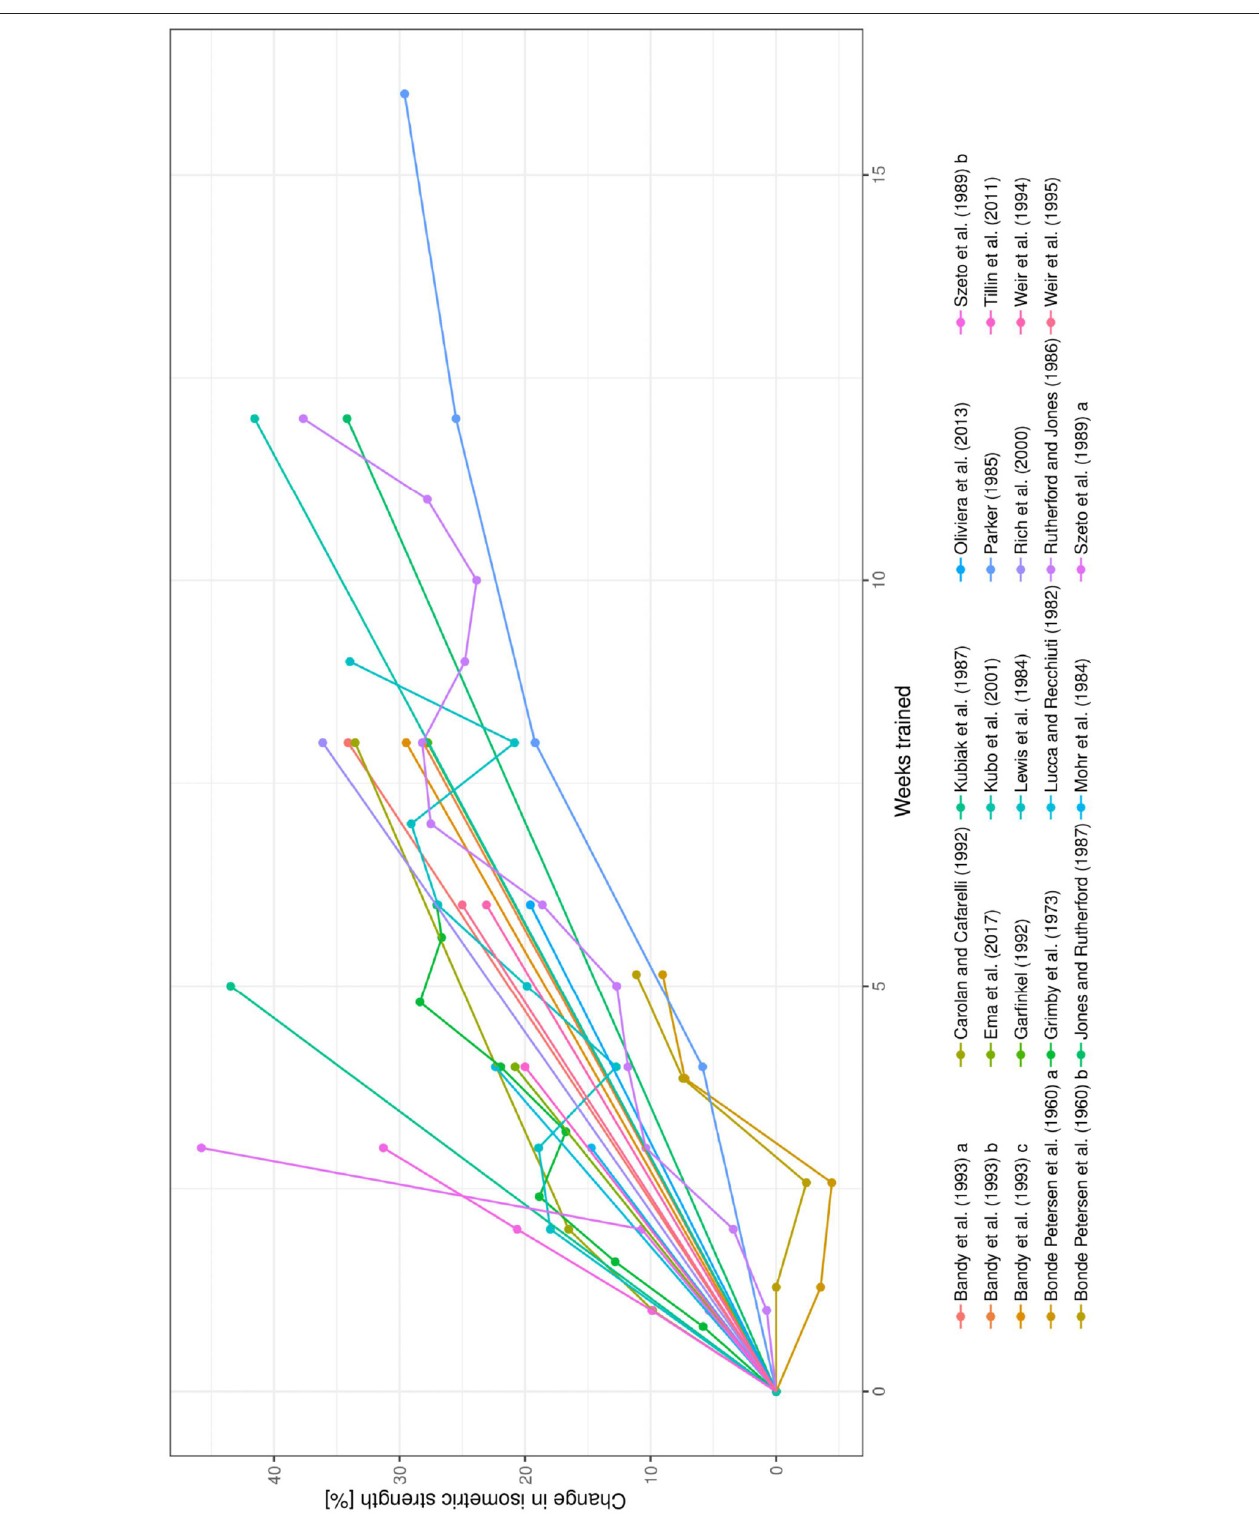
FIGURE 1 | Spaghetti plot of the data on change in isometric strength over time in weeks for all studies included in the systematic review.